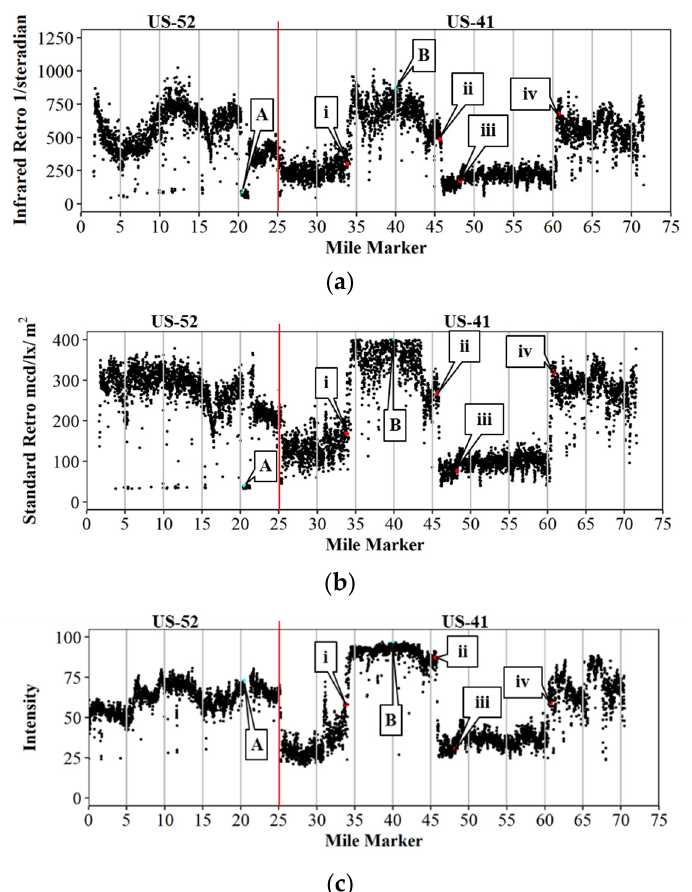
Figure 5. Northbound right edge line retroreflective and LiDAR intensity readings: ( a ) infrared retroreflective values; ( b ) standard retroreflective values; ( c ) LiDAR intensity values.